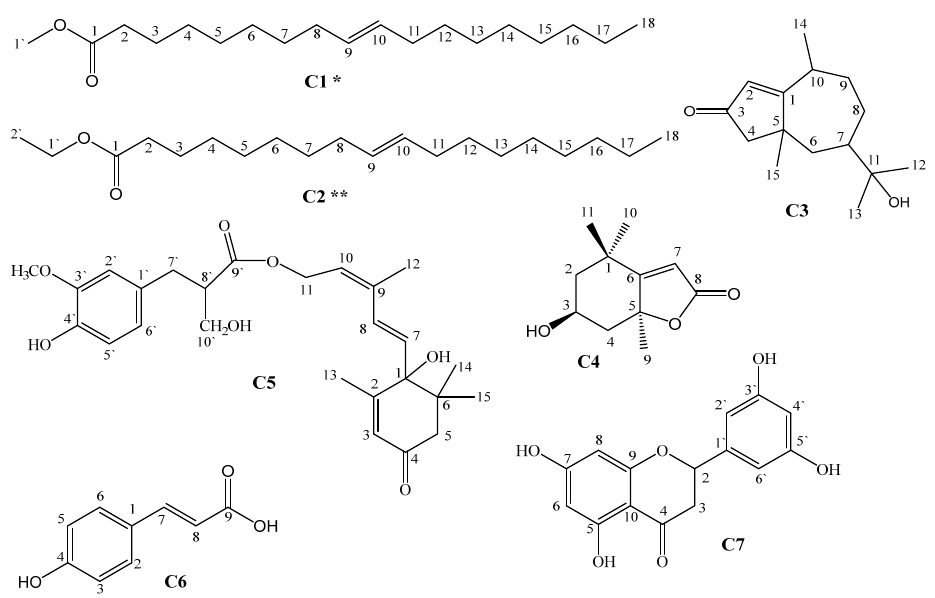
Figure 1. Structures of isolated compounds from Echinops erinaceus ( C1 , C2 , C3 – C7 ).